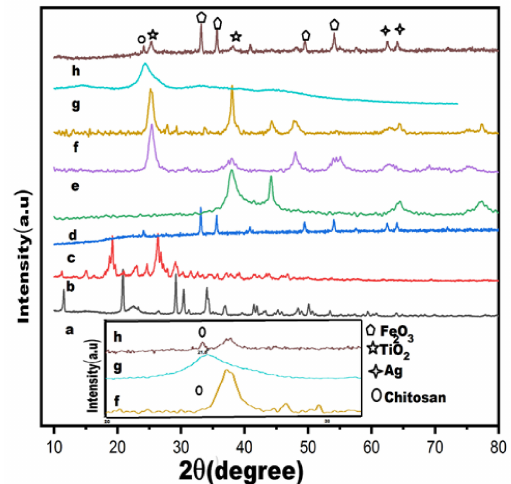
Figure 3. XRD spectrum of synthesized nanomaterials. ( a ) CIP, ( b ) pure plant powder, ( c ) pure Fe 2 O 3 , ( d ) pure Ag NPs, ( e ) pure TiO 2 NPs, ( f ) Ag/TiO 2 nanohybrid, ( g ) pure CS NPs, ( h ) CIP- Ag/TiO 2 /Fe 2 O 3 /CS nanoformulation (NDDS). A zoom image is provided for ( f , g , h ) which